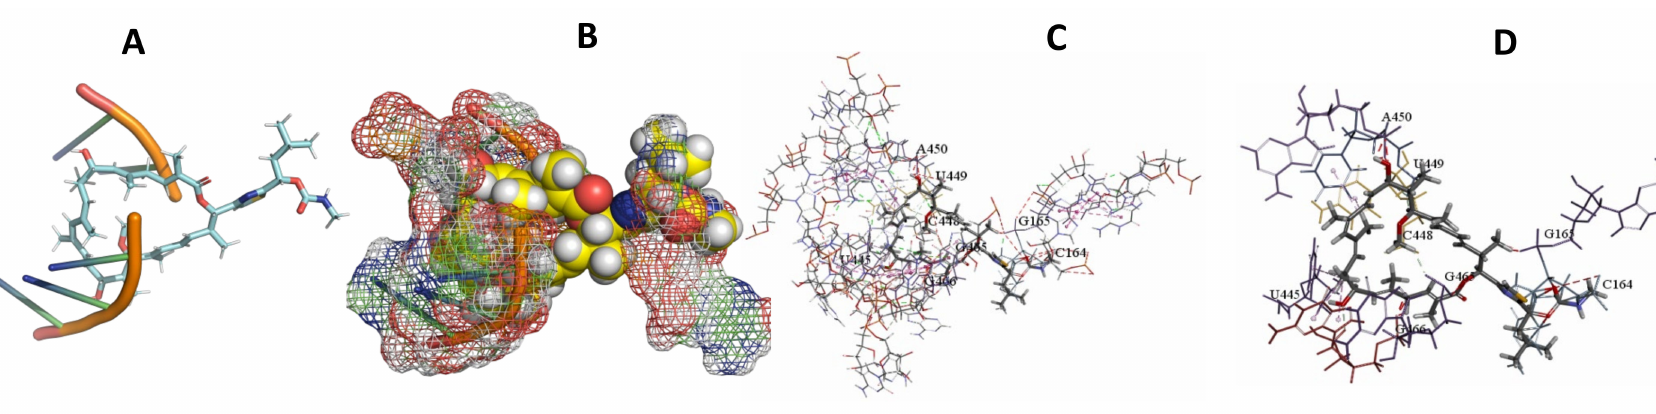
Figure 15. L. major + Archazolid. ( A ): Best binding pose and nucleotides involved. ( B ): Schematic binding pocket. ( C ): shows the Nucleotides component that re involved in binding. ( D ): Shows the main bonds involved between the compound and the nucleotide